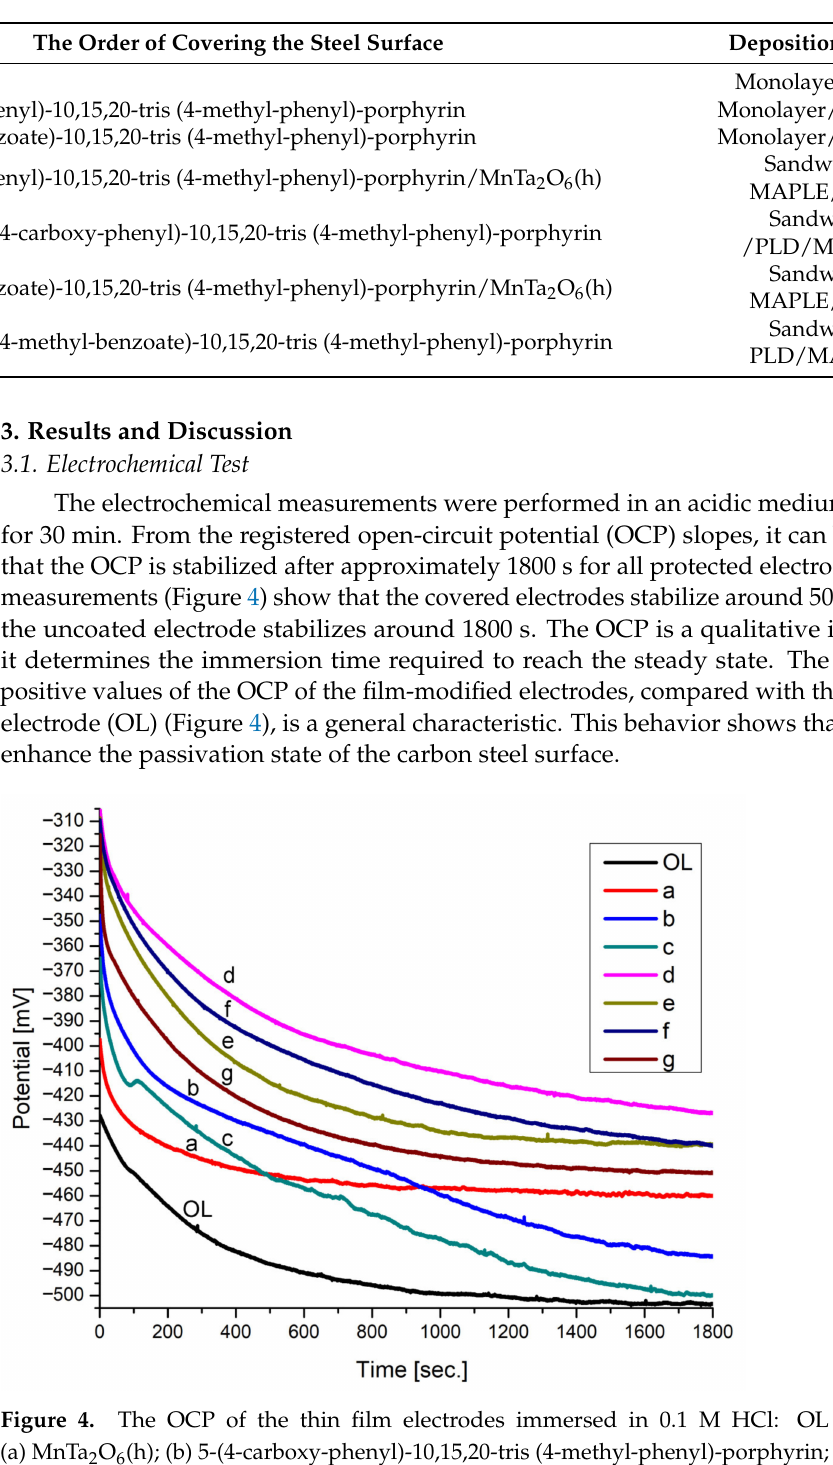
Table 1. Nature of the inhibitors and their order of deposition on W1.4043 steel.